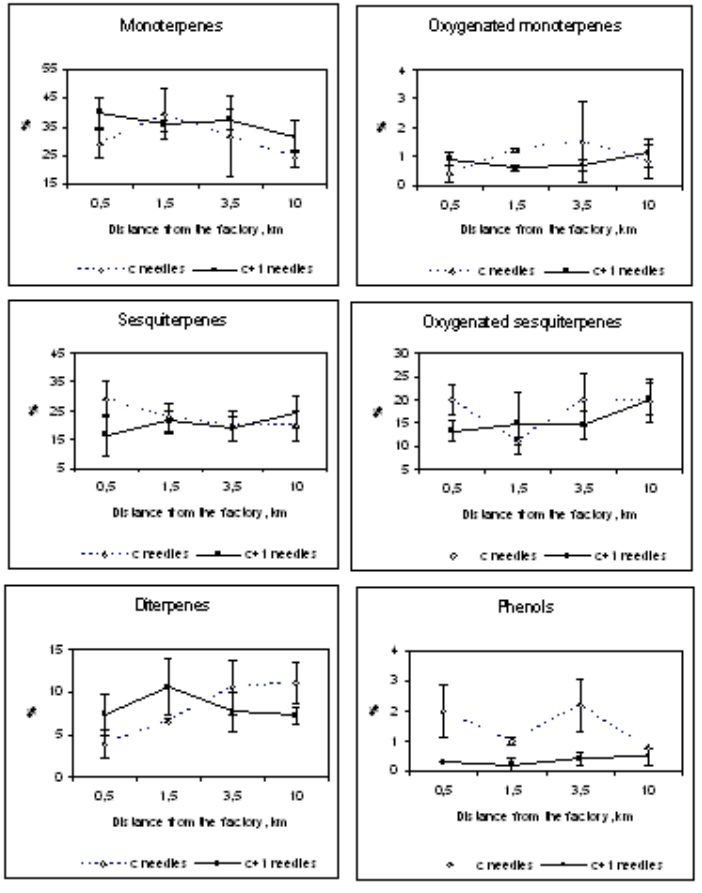
FIGURE 1. Percentage composition (mean values, n = 4) of the main classes of essential oils (monoterpenes, oxygenated monoterpenes, sesquiterpenes, oxygenated sesquiterpenes, diterpenes, phenols) in current-year (c) and 1-year-old needles (c+1) of Scots pine ( P. sylvestris L.) stands growing at different distances from the cement factory (July 10, 2005). Error bars indicate an interval of 95%